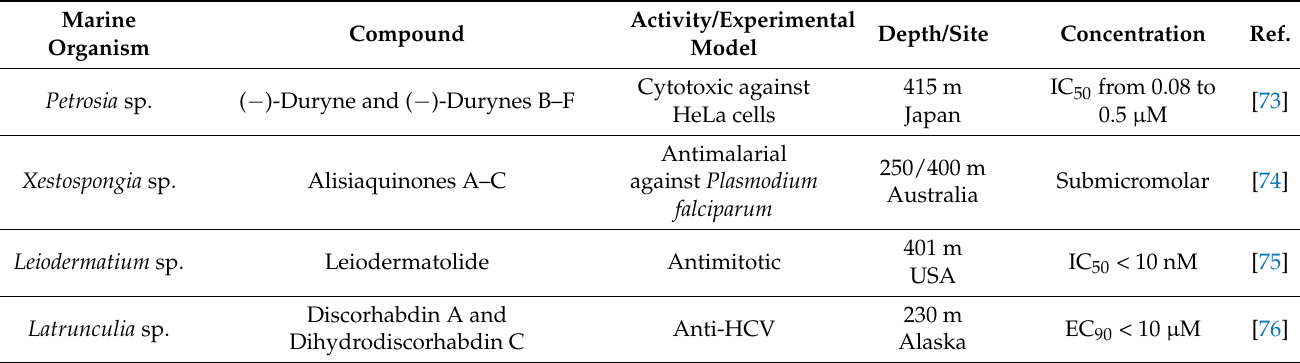
Table 4. Bioactive compounds from deep-sea